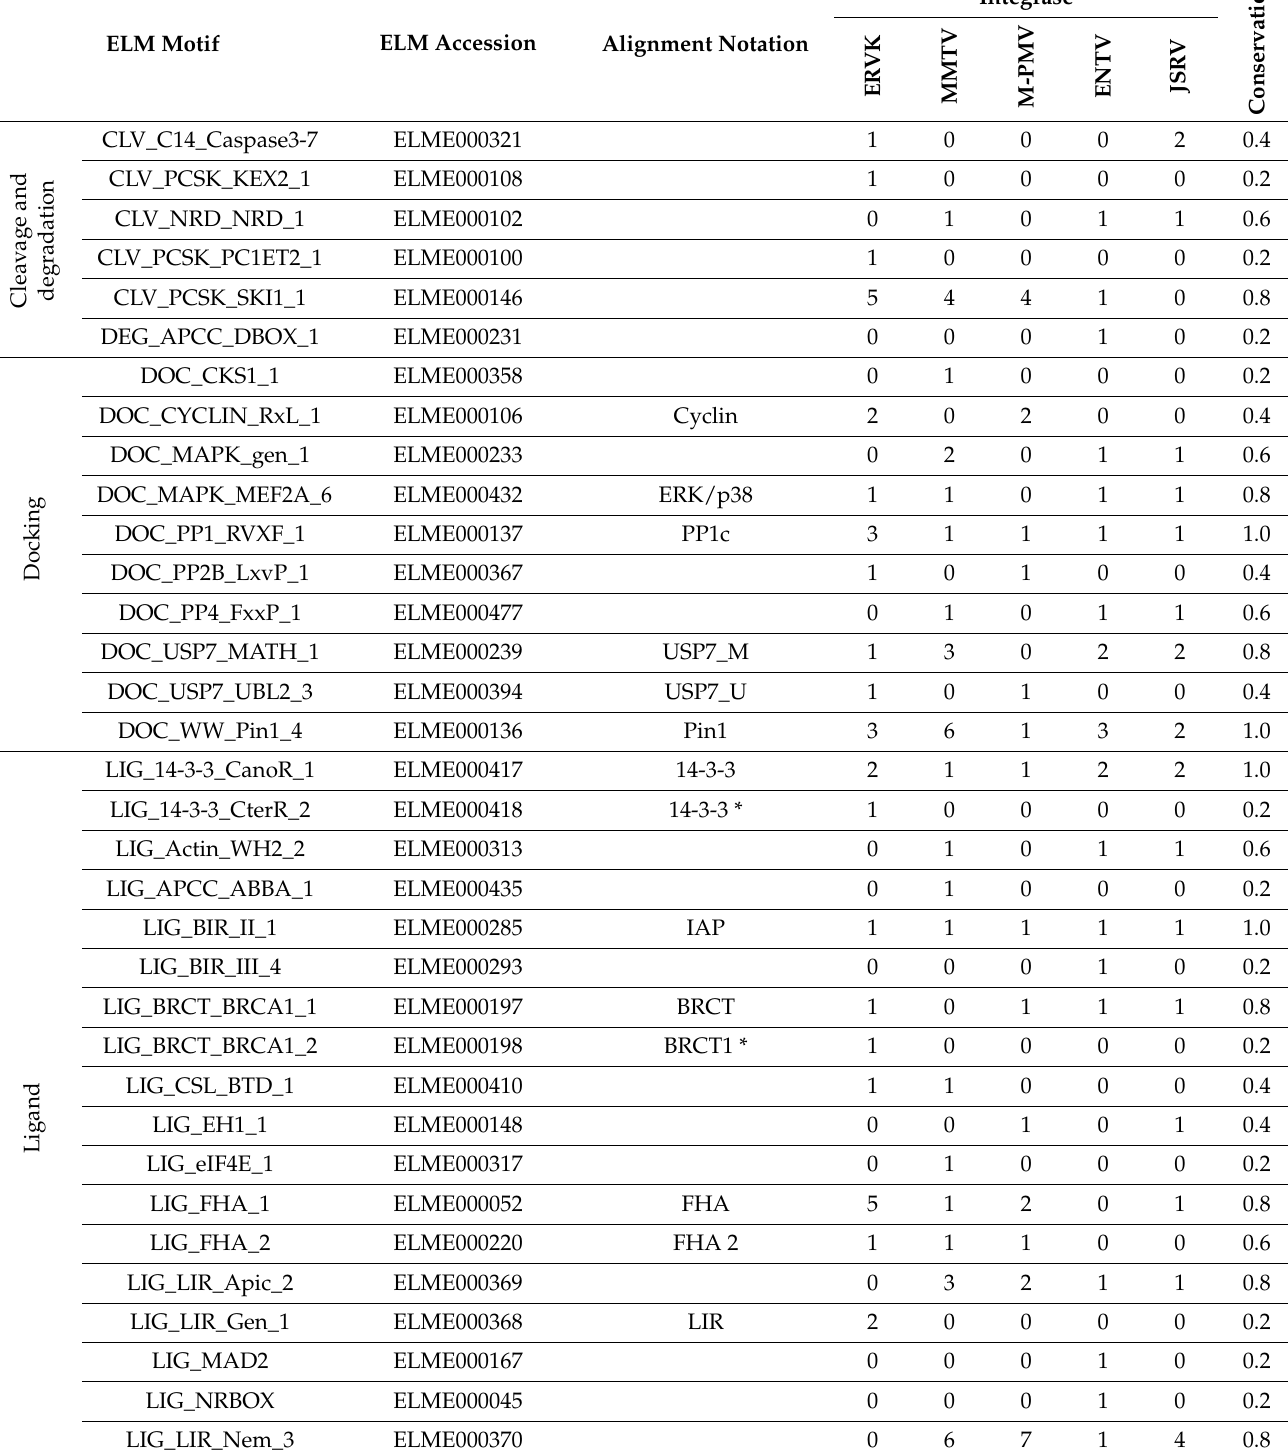
Table 1. ELM motifs in integrases from ERVK and exogenous